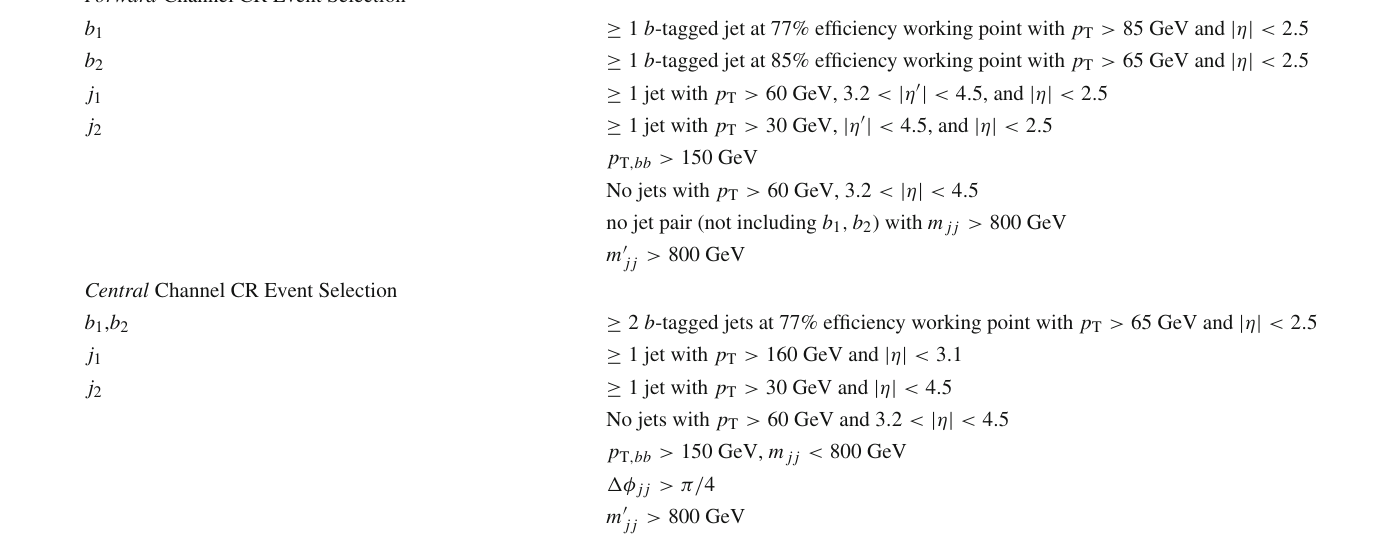
Table 3 Event selection criteria for the Forward and Central channel CRs. The p T and | η | requirements on the offline jets are used to match trigger selections and flavour-tagging requirements. The variables η (cid:7)